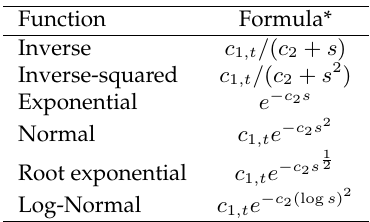
Table 1: Potential functions used to derive probabilities from ∆ T i ( t ) in field-based time geography. * c 1 ,t is a time-varying scaling parameter, c 2 is a time-decay tuning parameter and s = ∆ T i,t